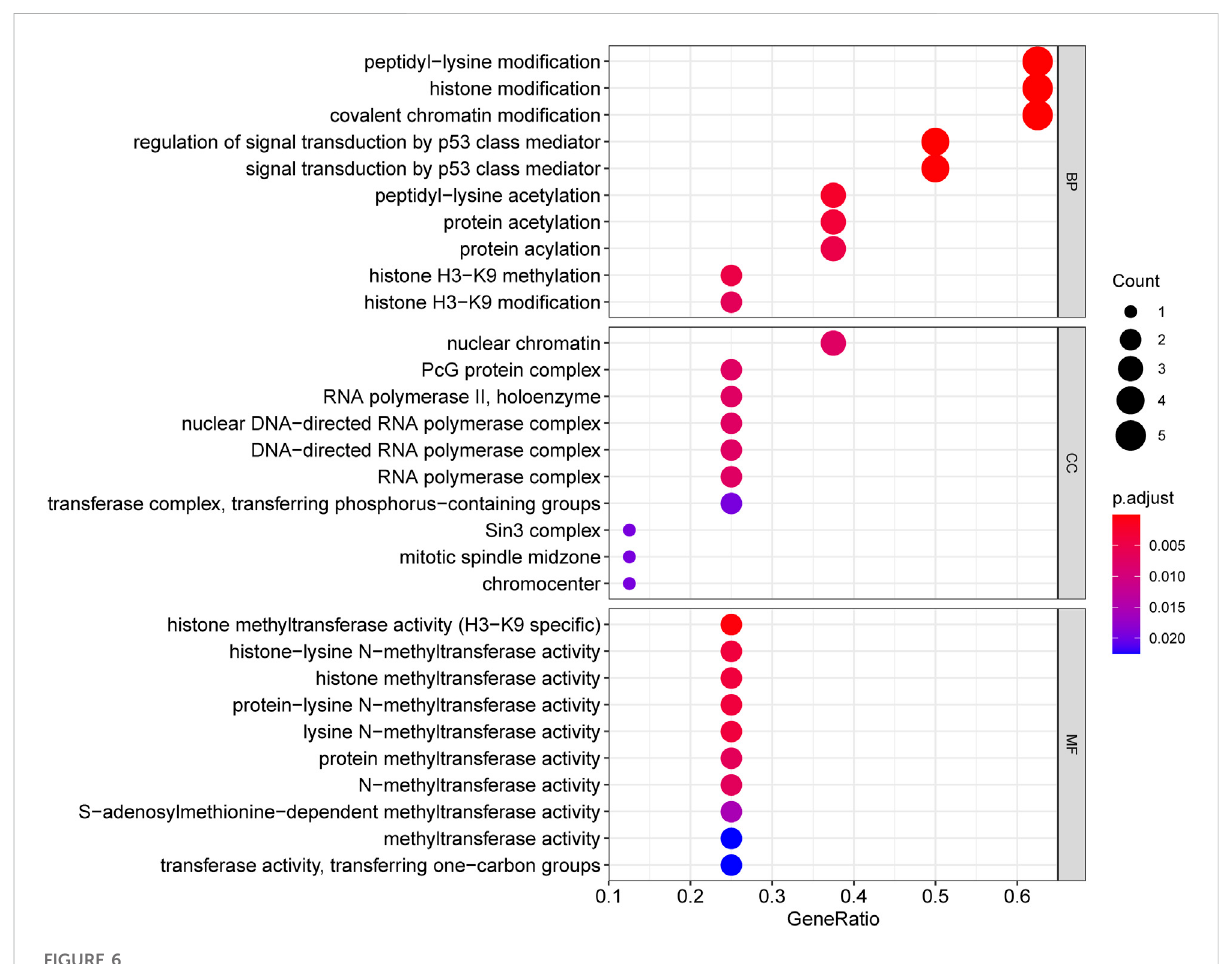
FIGURE 6 GO_BP, CC and MF analysis of 20